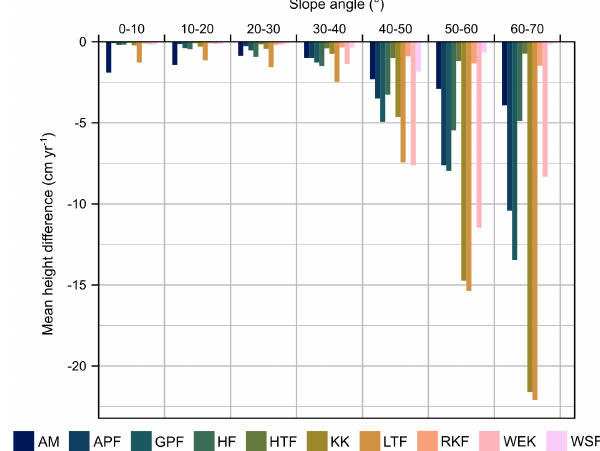
Figure 13. Mean annual height difference (based on the DoDs of the study areas covering time period 2; see Table 4 for specific DoDs) depending on the slope angle (colour map batlow10 from Crameri et al.,